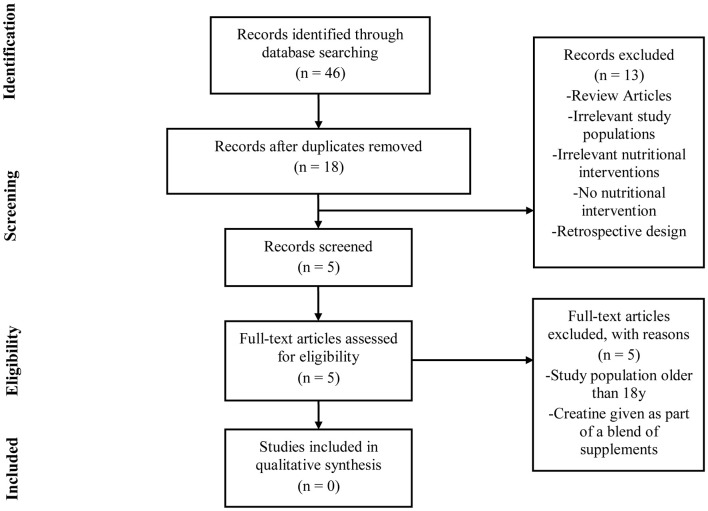
PRISMA flow chart.